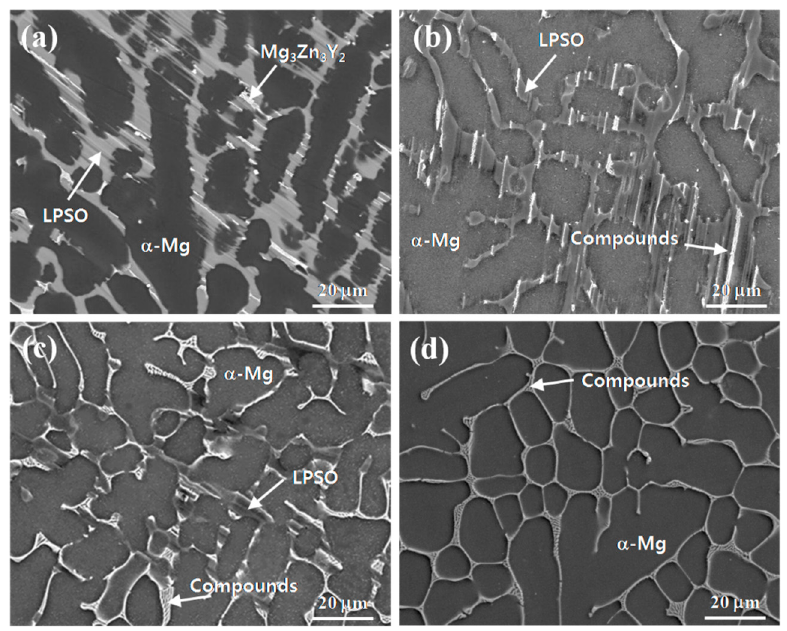
Figure 2. SEM microstructure of the as-cast alloys: ( a ) Mg 88.5 Zn 5 Y 6.5 ; ( b ) Mg 88.5 Zn 5 Y 5.0 Yb 1.5 ; ( c ) Mg 88.5 Zn 5 Y 3.5 Yb 3.0 ; ( d ) Mg 88.5 Zn 5 Y 2.0 Yb 4.5 .